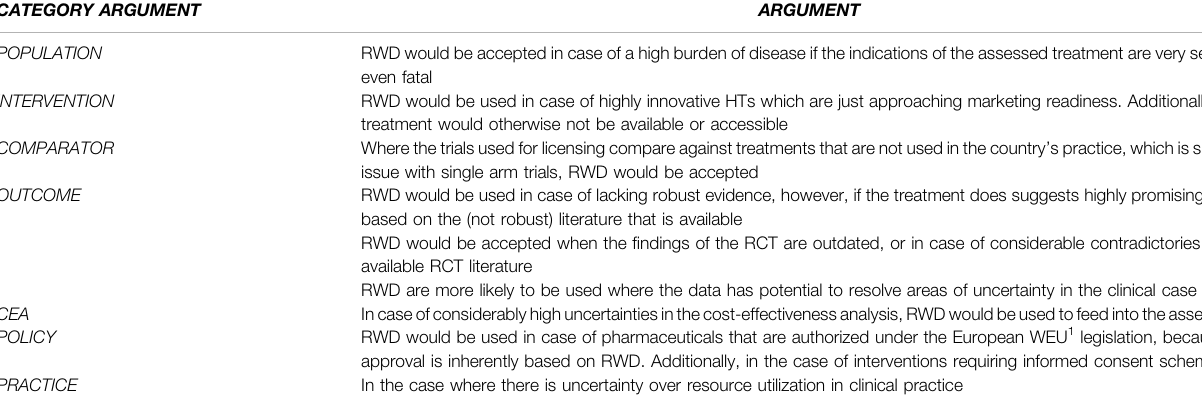
Frontiers in Pharmacology |